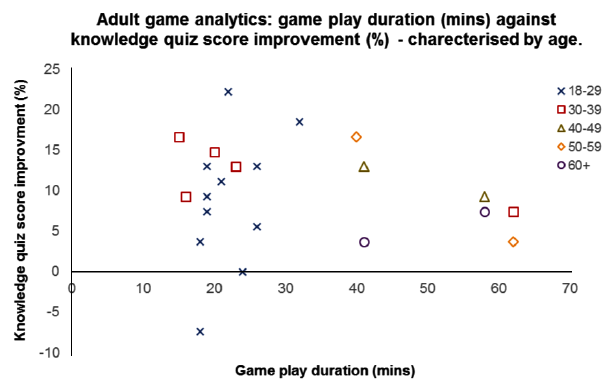
Figure 5. Graph showing the preliminary results for the data re- trieved from in-built gaming analytics for the adult participants ( N =